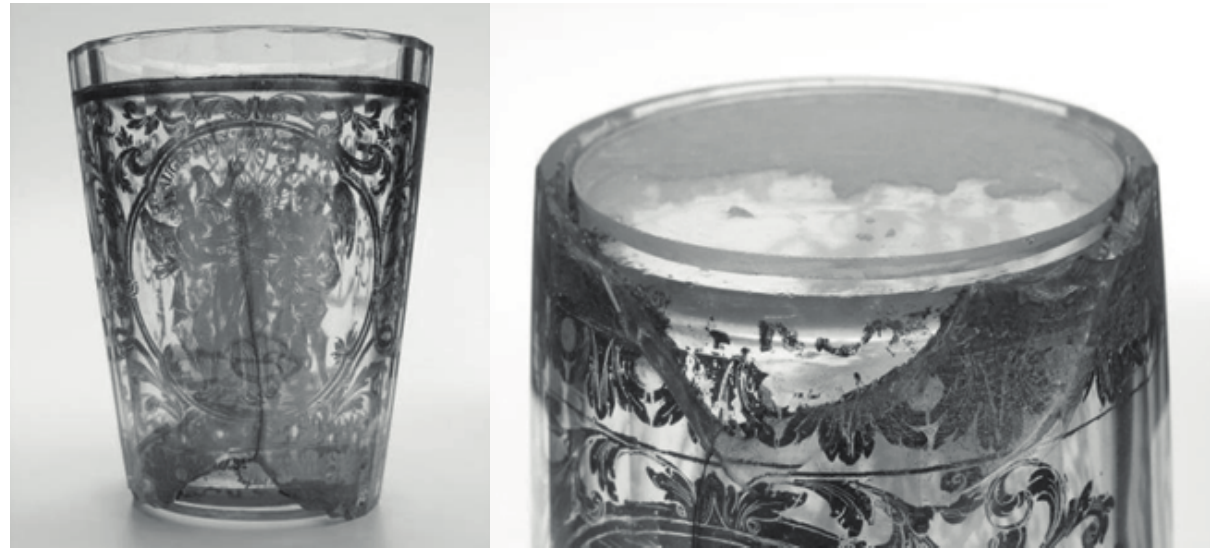
Figure 6. Historical cup restored using a preparation based on PHEMA. (a) an example of gluing glass on a base, (b) a detail of an attached substitutive